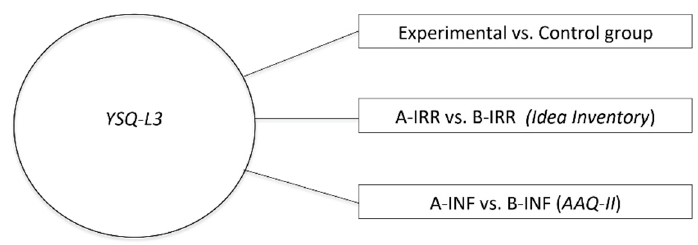
Figure 2. Schematic representation of the data analysis.